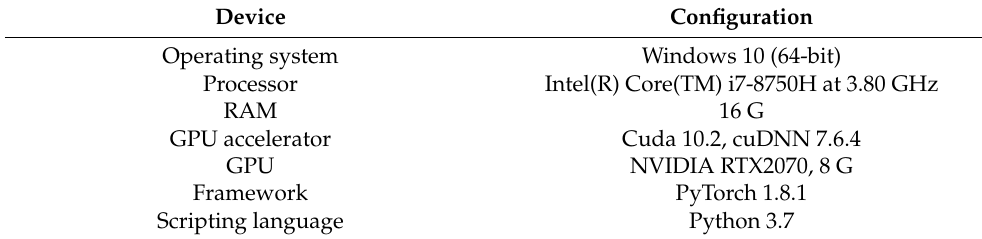
Table 2. Configuration parameters.